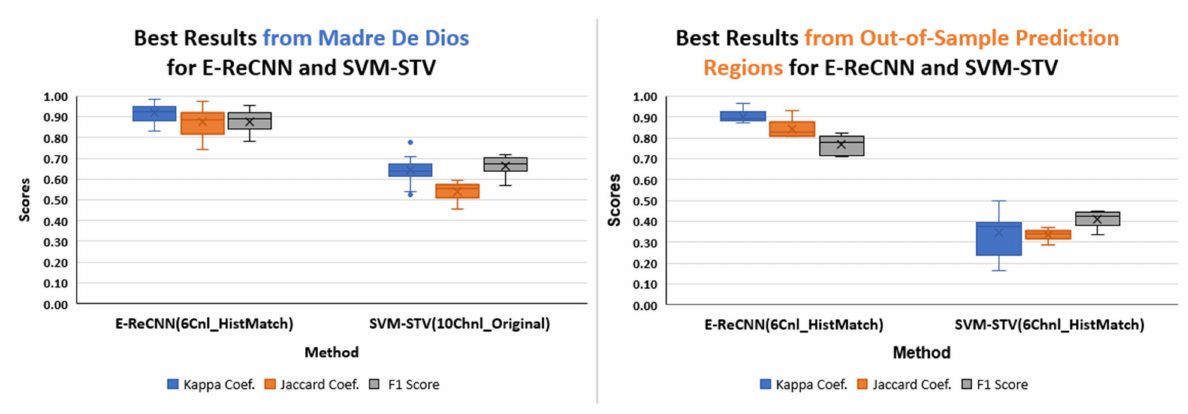
Figure 6. ( left ) Average scores of model performance across the 16 MDD regions for both E-ReCNN and SVM-STV. The highest accuracies were generated with the 6-channel set of histogram-matched data for E-ReCNN and with the 10-channel data for SVM-STV. Blue dots for the Kappa Coefficient of SEVM-STV results indicate the outliers that are higher and lower than the variance line edges. ( right ) Average scores of model performance for out-of-sample test regions in Indonesia, Myanmar, and Venezuela for both E-ReCNN and SVM-STV. The highest accuracies were generated with the 6-channel set of histogram-matched data for E-ReCNN and with the 6-channel histogram-matched data for SVM-STV. For both left and right, blue, orange, and gray boxes represent the distribution of Cohen’s Kappa coefficients, Jaccard coefficient, and F1-scores,